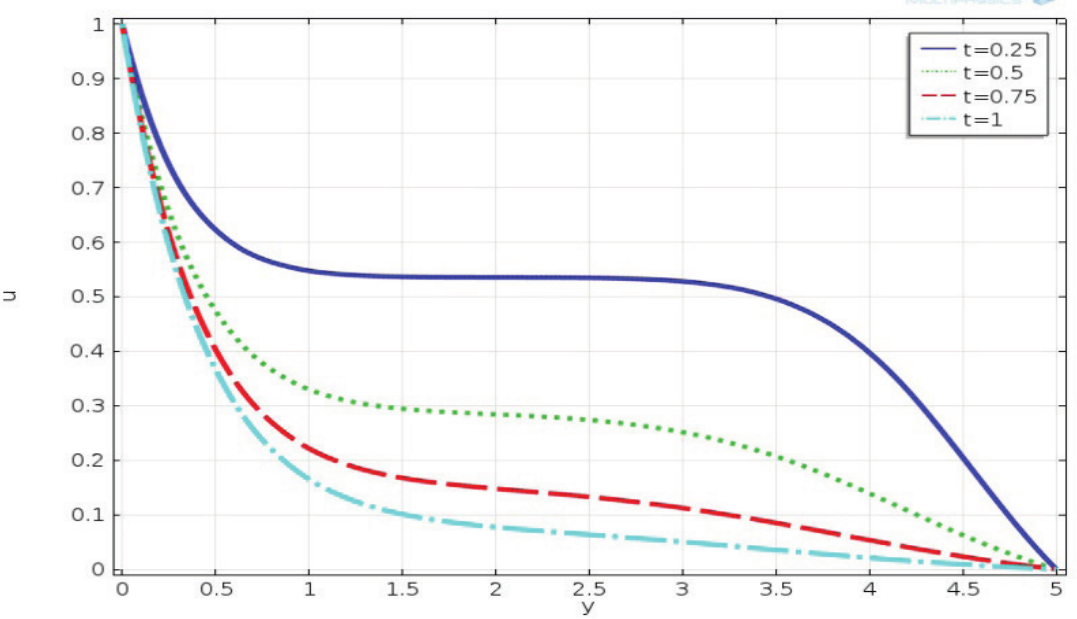
Figure 2: Velocity profiles for different times at